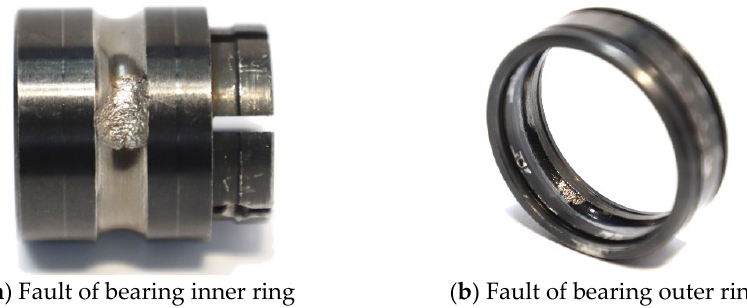
Figure 15. Pictures of bearing failure: ( a ) fault of the bearing inner ring; ( b ) fault of the bearing outer ring.